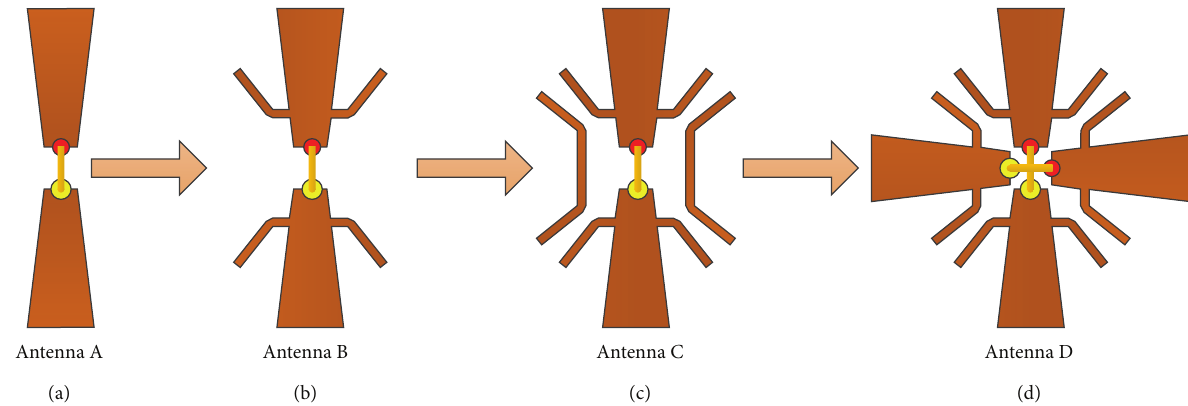
Figure 2: The evolution steps of the proposed antenna configuration: (a) a planar bowtie-shaped dipole (Antenna A), (b) a planar bowtie- shaped dipole with two curve parasitic elements (Antenna B), (c) a planar bowtie-shaped dipole with four curve parasitic elements (Antenna C), and (d) the proposed antenna (Antenna D).